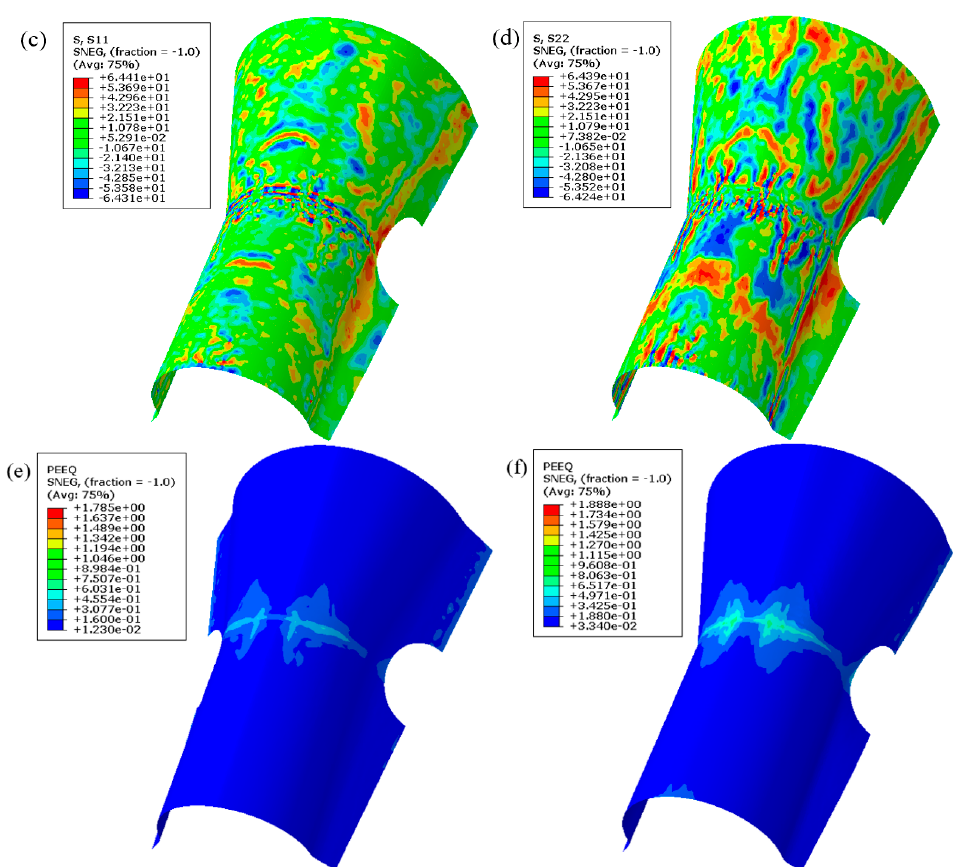
Figure 12. Stress and strain distribution in the two-step hot press forming process: ( a ) Axial stress in the first step; ( b ) hoop stress in the first step; ( c ) axial stress in the second step; ( d ) hoop stress in the second step; ( e ) equivalent strain in the first step; ( f ) equivalent strain in the second step.